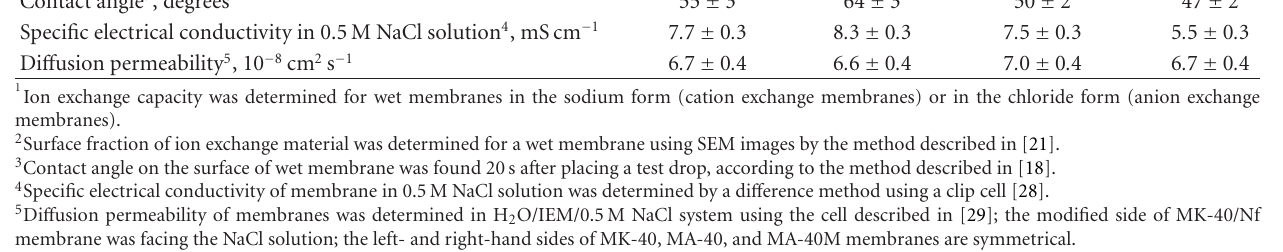
Table 1: Some characteristics of commercial MK-40, MA-40, and surface-modified MK-40/Nf and MA-40M membranes. Membranes Ion exchange groups, bulk Idem,